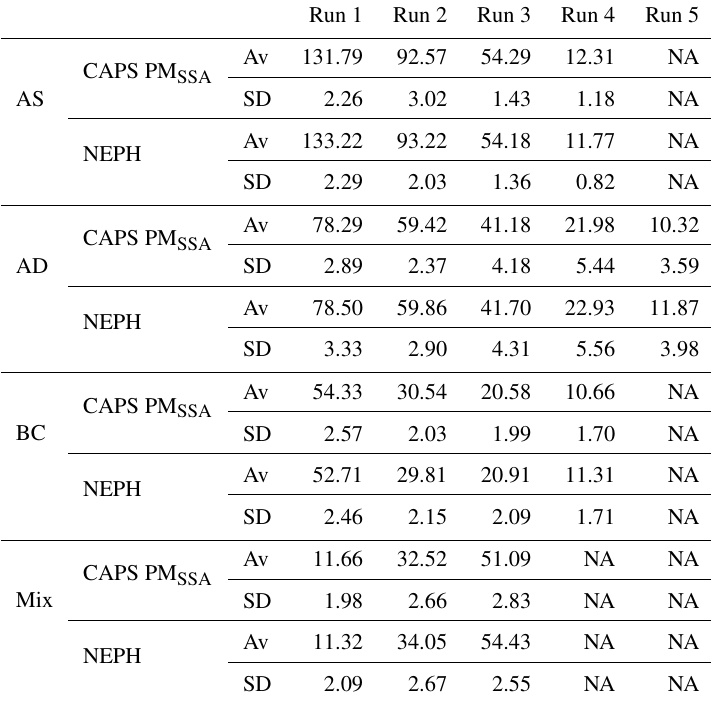
Table A2. Scattering coefficient mean and 1 σ of the mean measured by the CAPS PM SSA and NEPH.